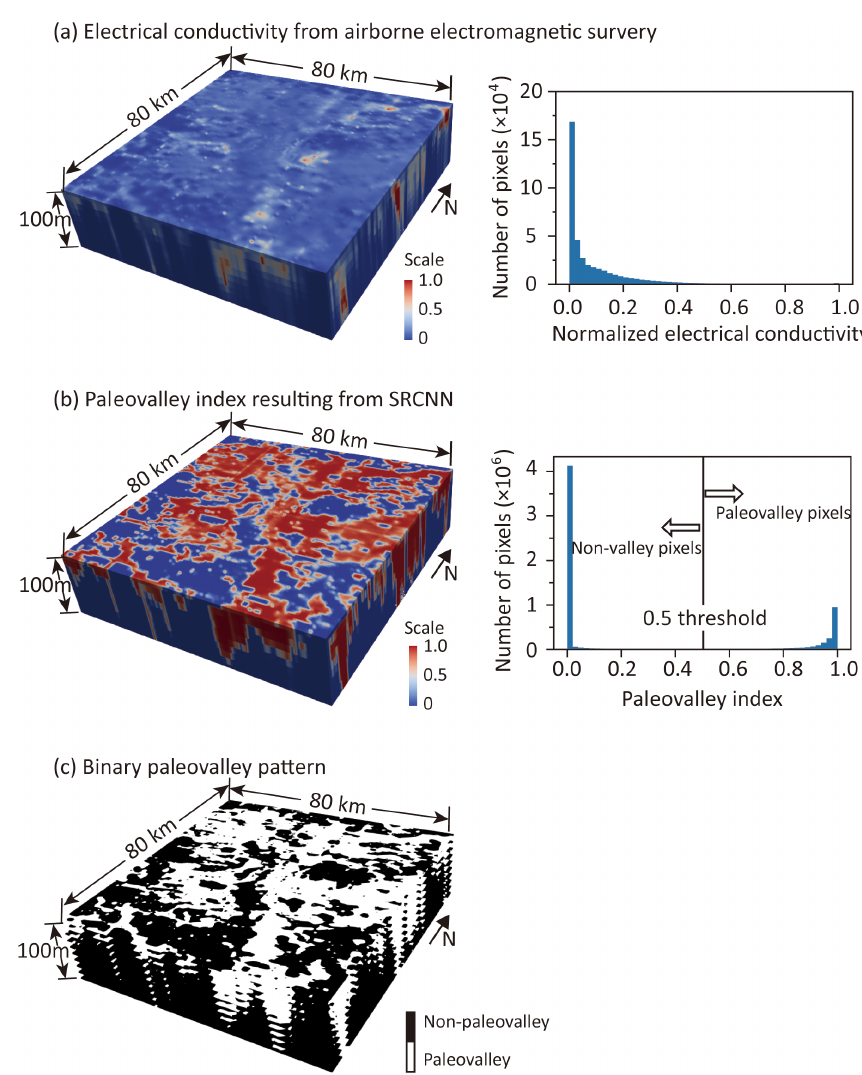
Figure 9. (a) Rescaled AEM-derived EC map and corresponding histogram of normalized EC values within the depth interval of 100m in an 80km × 80km region in APY lands, Australia; (b) paleovalley indices map and corresponding histogram after application of the trained SRCNN; (c) binary paleovalley